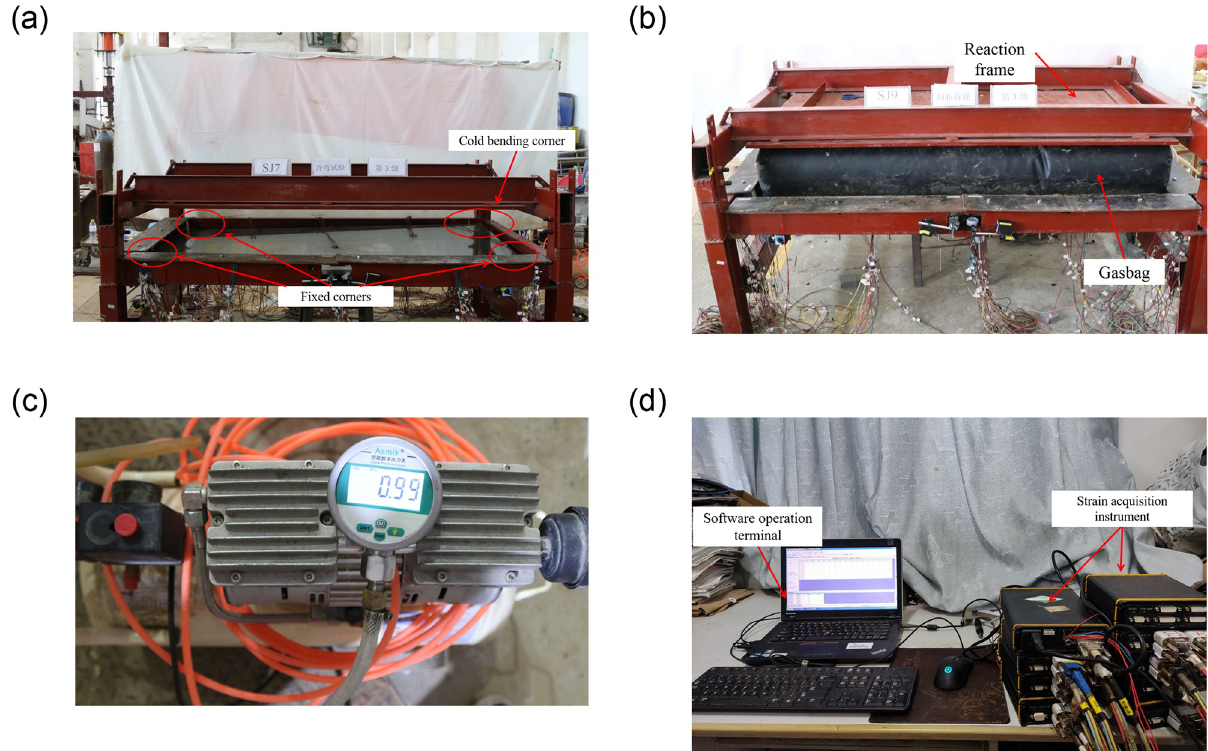
Fig 4. Real shot diagram and data acquisition system during the test. (a)Loading of cold bending; (b) Simulation of uniform load with gasbag; (c) gas pump and pressure gauge; (d) Strain acquisition system.